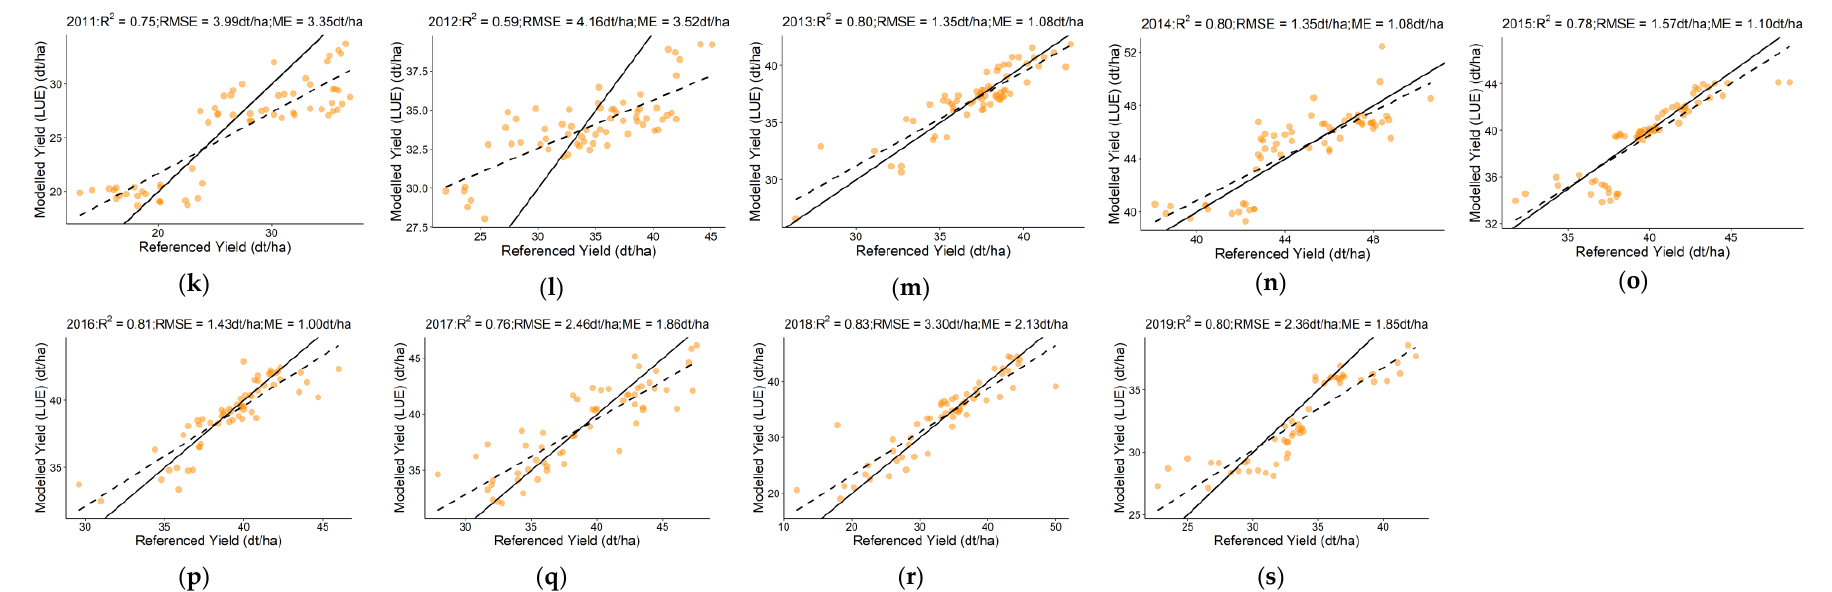
Figure A4. The scatter plots ( a – s ) compare the accuracies of modelled and referenced yields of OSR for 2001 to 2019. The values of the statistical parameters such as R 2 , RMSE (dt/ha), and ME (dt/ha) are displayed at the top of each plot. Every plot contains a solid line (1:1 line) that is used to visualise the correlation of pixels between the modelled and referenced yield values. The orange colour of scatter plots represents OSR.